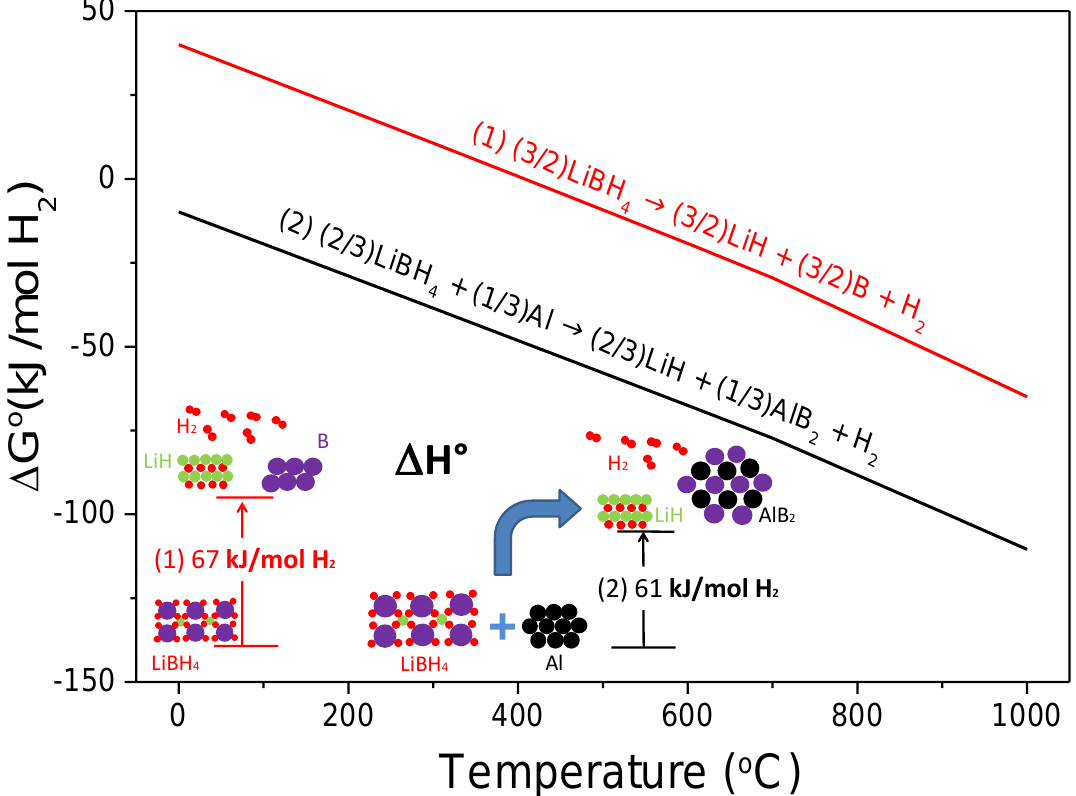
Figure 3. Free energy per mol of H 2 as a function of temperature and standard enthalpy of reaction of the hydride system 2LiBH 4 + Al.